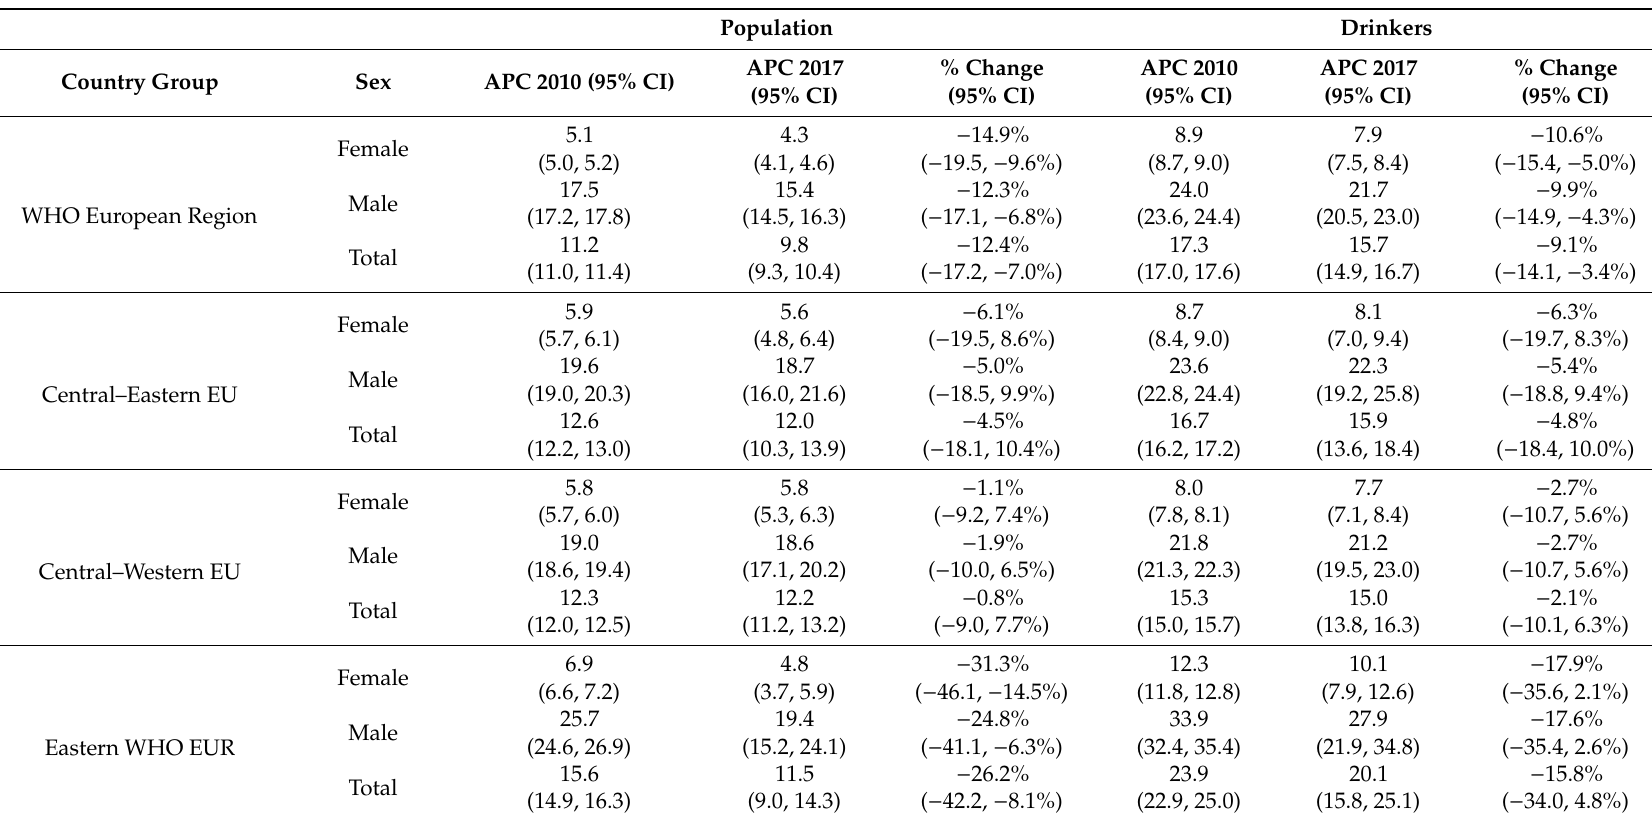
Table 2. Alcohol per capita consumption (APC) in liters of pure alcohol in 2010 and 2017 and relative change in APC in the World Health Organization European Region and six nondisjoint country groups among the total adult population and current